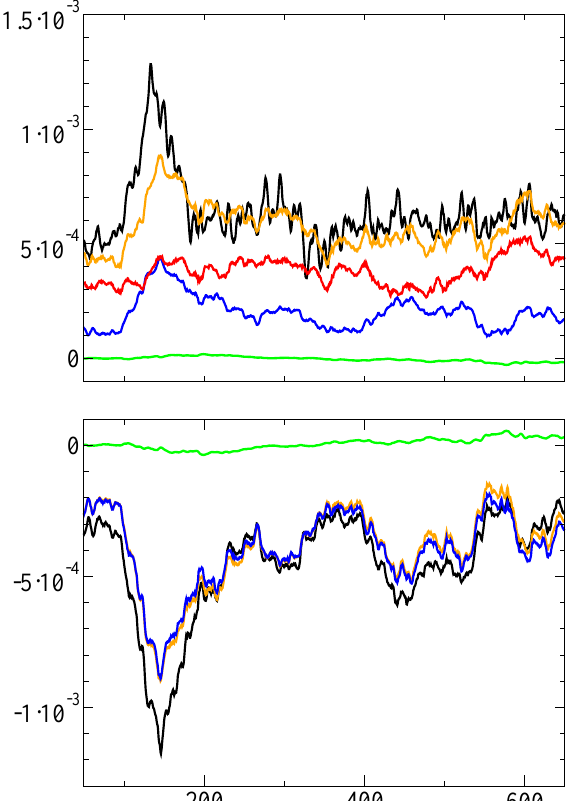
Fig. 8. Same as Fig. 7, but for another run of the top panel of Fig. 4, i.e., β = 2 . 4 and d i /l f = 0 . 23. The same color code is used: black: total r.h.s.; orange: sum of all the non-gyrotropic pressure contri- butions; red: term involving tr ( 5 i ·∇ u i ) s ; green: term involving ( 5 i ·∇ u i ) s : τ ; blue: term involving 5 i : d τ